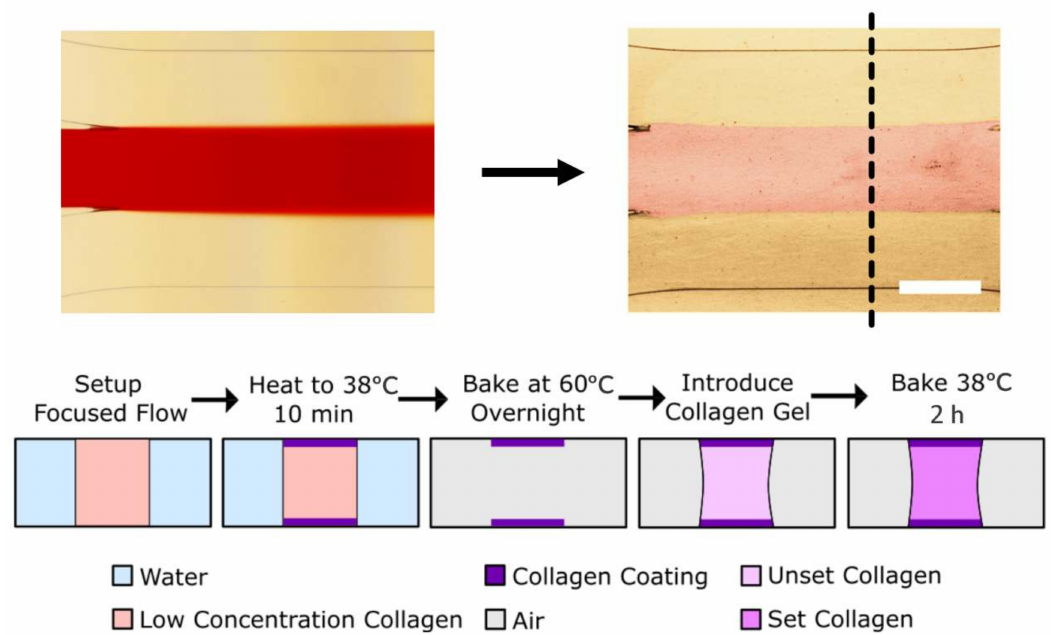
Figure 2. We show the process for selectively patterning a hydrophilic path in the middle of a channel via laminar flow patterning, and show that a cured hydrogel is easily confined to this pre-defined area. In the top left, a stream containing 10 µ g / mL of collagen is confined to the center of the channel by its neighboring flows. The stream is artificially colored red for contrast. Subsequently, as shown on the top right, a high concentration of collagen (artificially colored pink for contrast) is confined to the patterned area and has gelled in place. Bottom shows the step-by-step procedure in schematic cross-section. Sections taken at dashed line in the top right image. Scale bar is 0.5